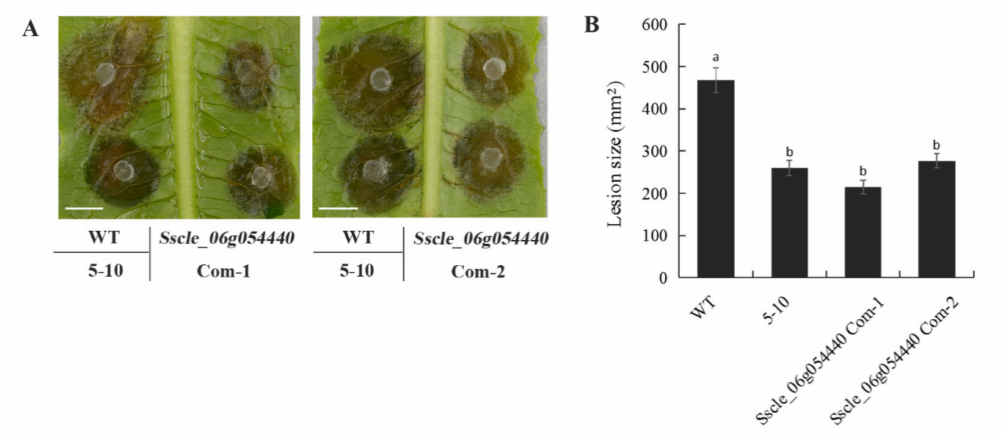
Figure 4. Sscle_06g054440 failed to complement the defects of 5–10. ( A ) Necrotic lesions on lettuce leaf due to S.sclerotiorum infection by the indicated strains. Bar = 10 mm. Data were recorded at 36 h post-inoculation (hpi). ( B ) Quantification of the lesion size of WT, 5–10, Sscle_06g054440 transgenic lines on lettuce leaves. ImageJ was used to analyze lesion size. Error bars represent SE. Statistical significance was analyzed using Student’s t -test. a and b represent different significance